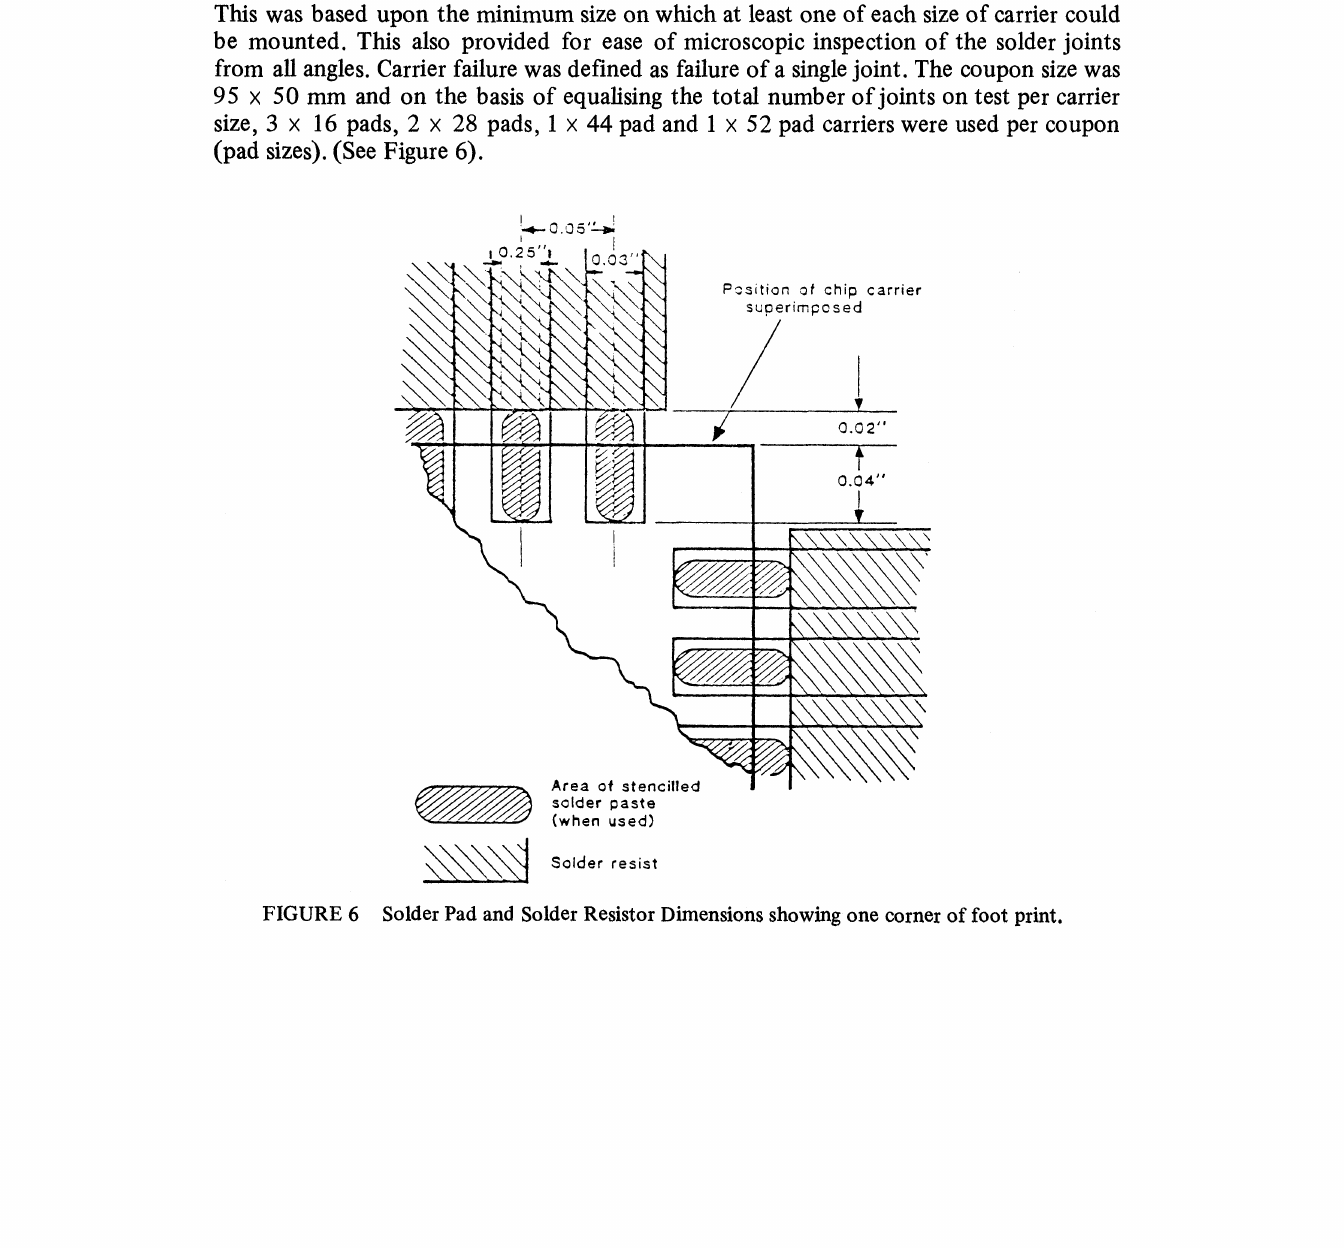
FIGURE 6 Solder Pad and Solder Resistor Dimensions showing one corner of foot